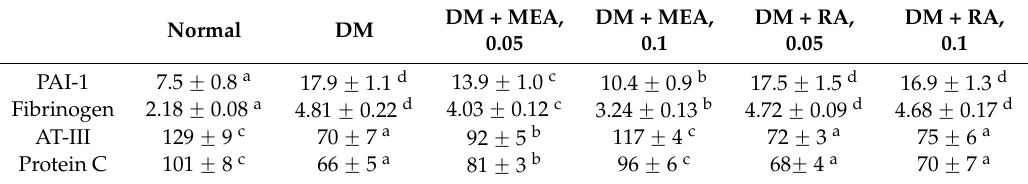
a–d Means in a row without a common letter differ, p < 0.05. Table 3. Level of triglyceride (TG) and total cholesterol (TC) in plasma (g/L) and liver (mg/g wet tissue) from normal (non-diabetic), diabetic mice consumed normal diet (DM), or 0.05%, 0.1% MEA or RA for six weeks. Data are mean ± SD, n = 10.